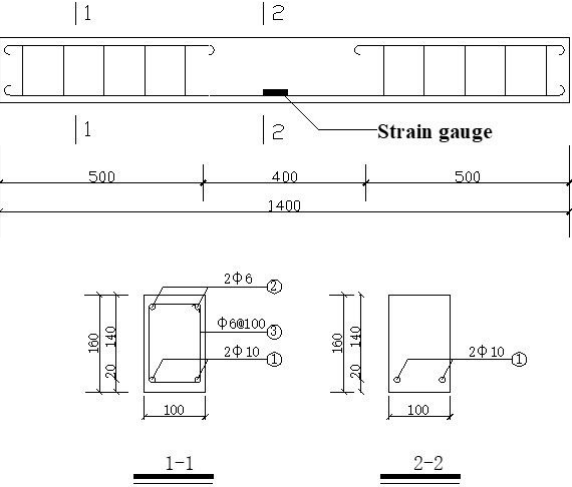
Figure 5: Design details of the beam